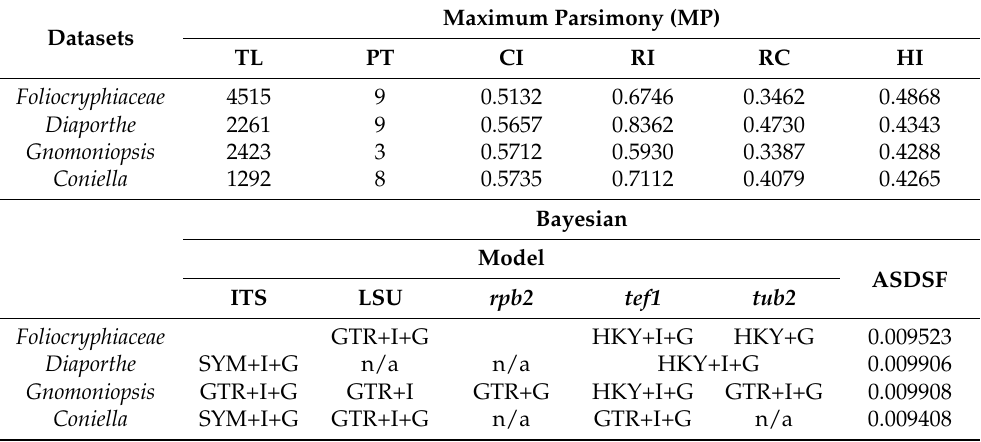
Table 6. Parameters of maximum parsimony and Bayesian methods in this